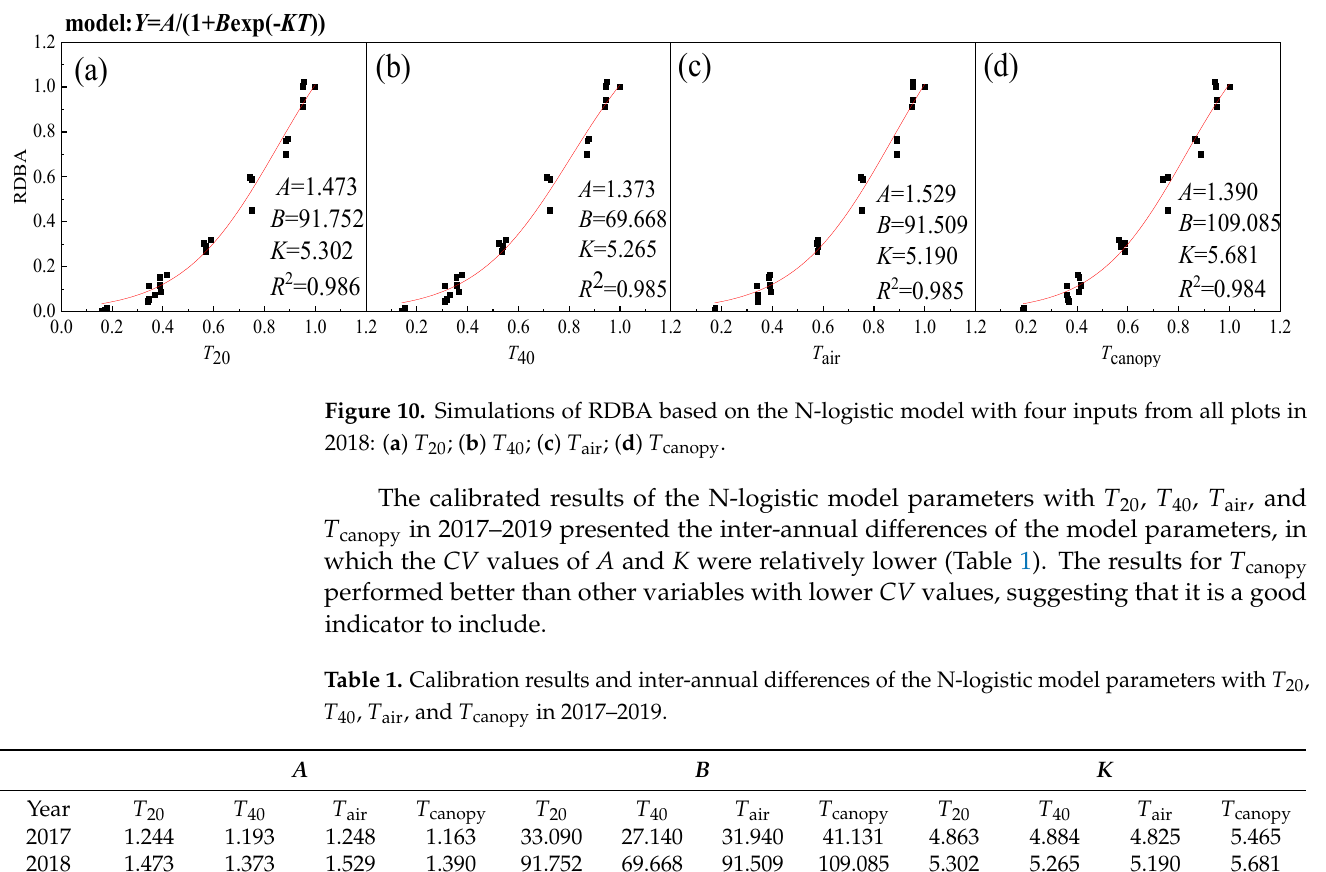
Table 2. Validation results of the N-logistic model of RDBA with T 20 , T 40 , T air , and T canopy between the simulated and observed data from five plots in 2017–2019.